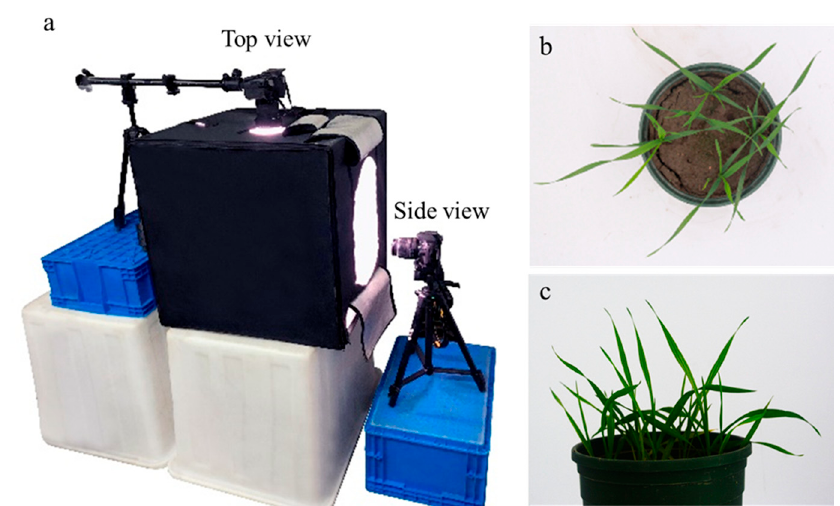
Figure 1. Self-made photography device ( a ) to obtain the digital images of the top view ( b ) and side view ( c ).